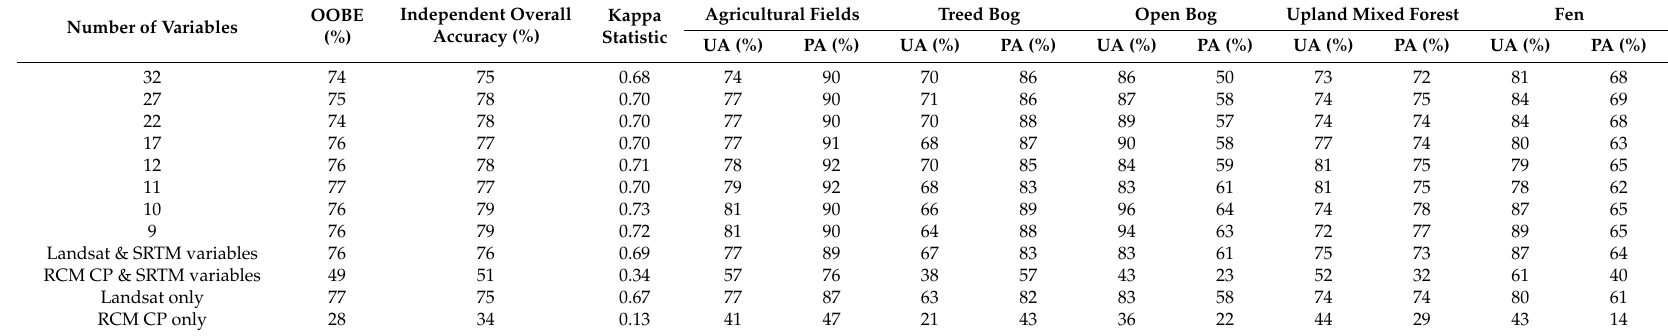
Table A10. Statistical results from the RCM CP NESZ − 25 dB (13 July 2014), Landsat-8 (27 June 2014), SRTM variables summer model. The first iteration was run with all 32 variables, and variables ranked to be unimportant were then removed until 9 variables remained. The final variables in the model with the highest independent overall accuracy (10 variables) in order of decreasing importance were the seven Landsat-8 bands, HV Intensity, Shannon Entropy Intensity, and SRTM DEM.